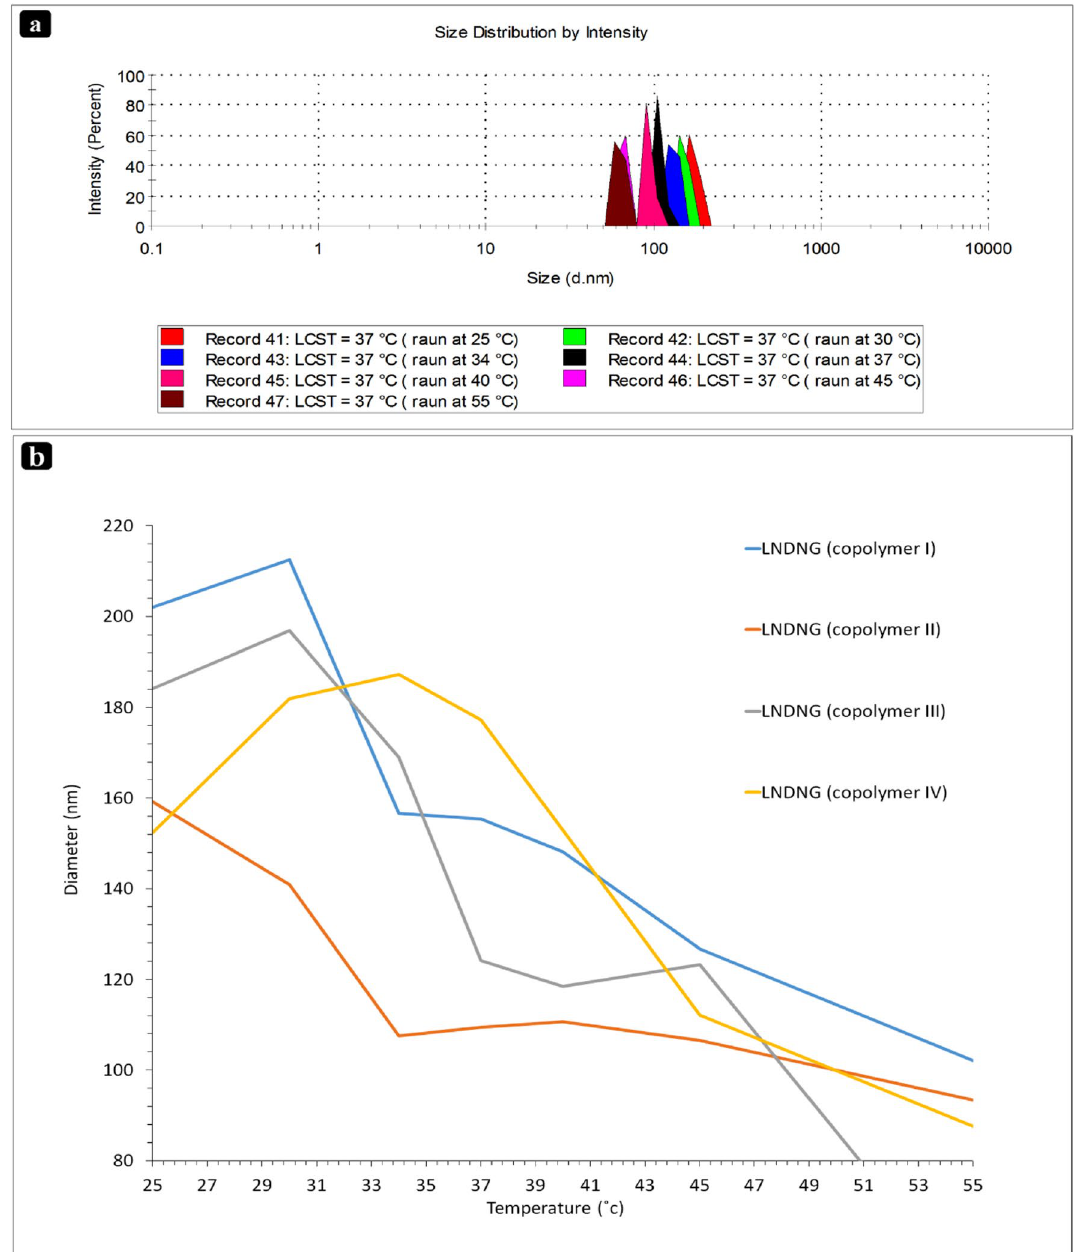
Figure 4. DLS results of nanogel systems: ( a ) nanogel particle size along with elevating temperature (from right to left, seven defined points of temperatures) and ( b ) diameter versus temperature of LNDNG